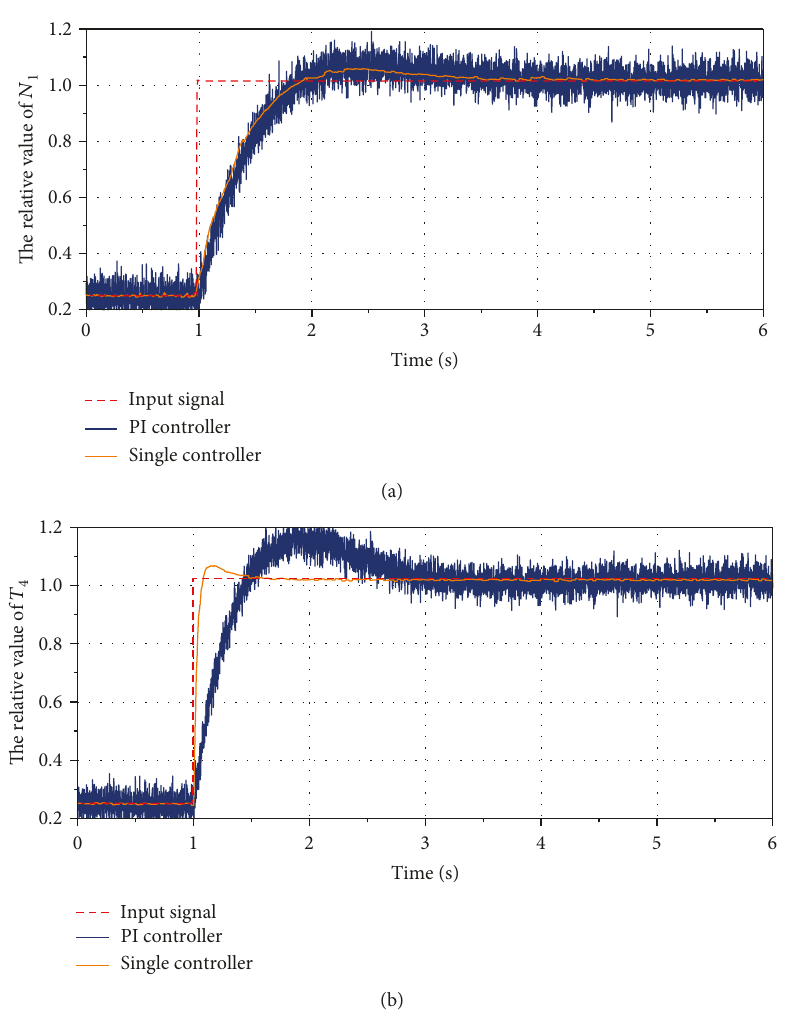
versus time (s). (b) 1